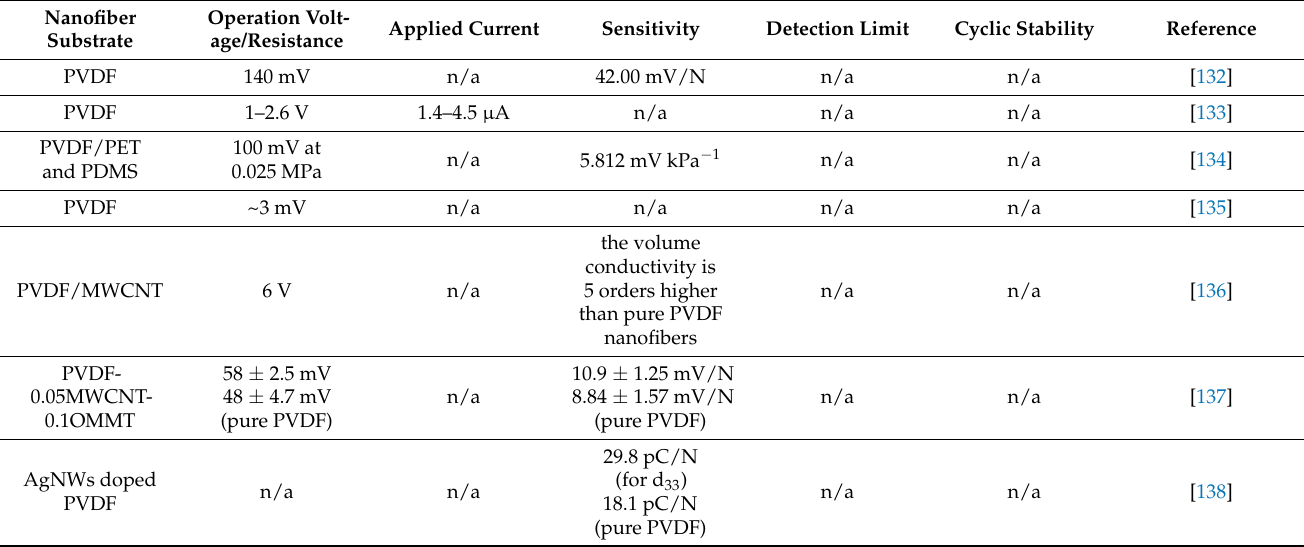
Table 7. The piezoelectric properties of PVDF, P(VDF-TrFE) nanofibers and their nanocomposite via electrospinning. The table is compiled from data in